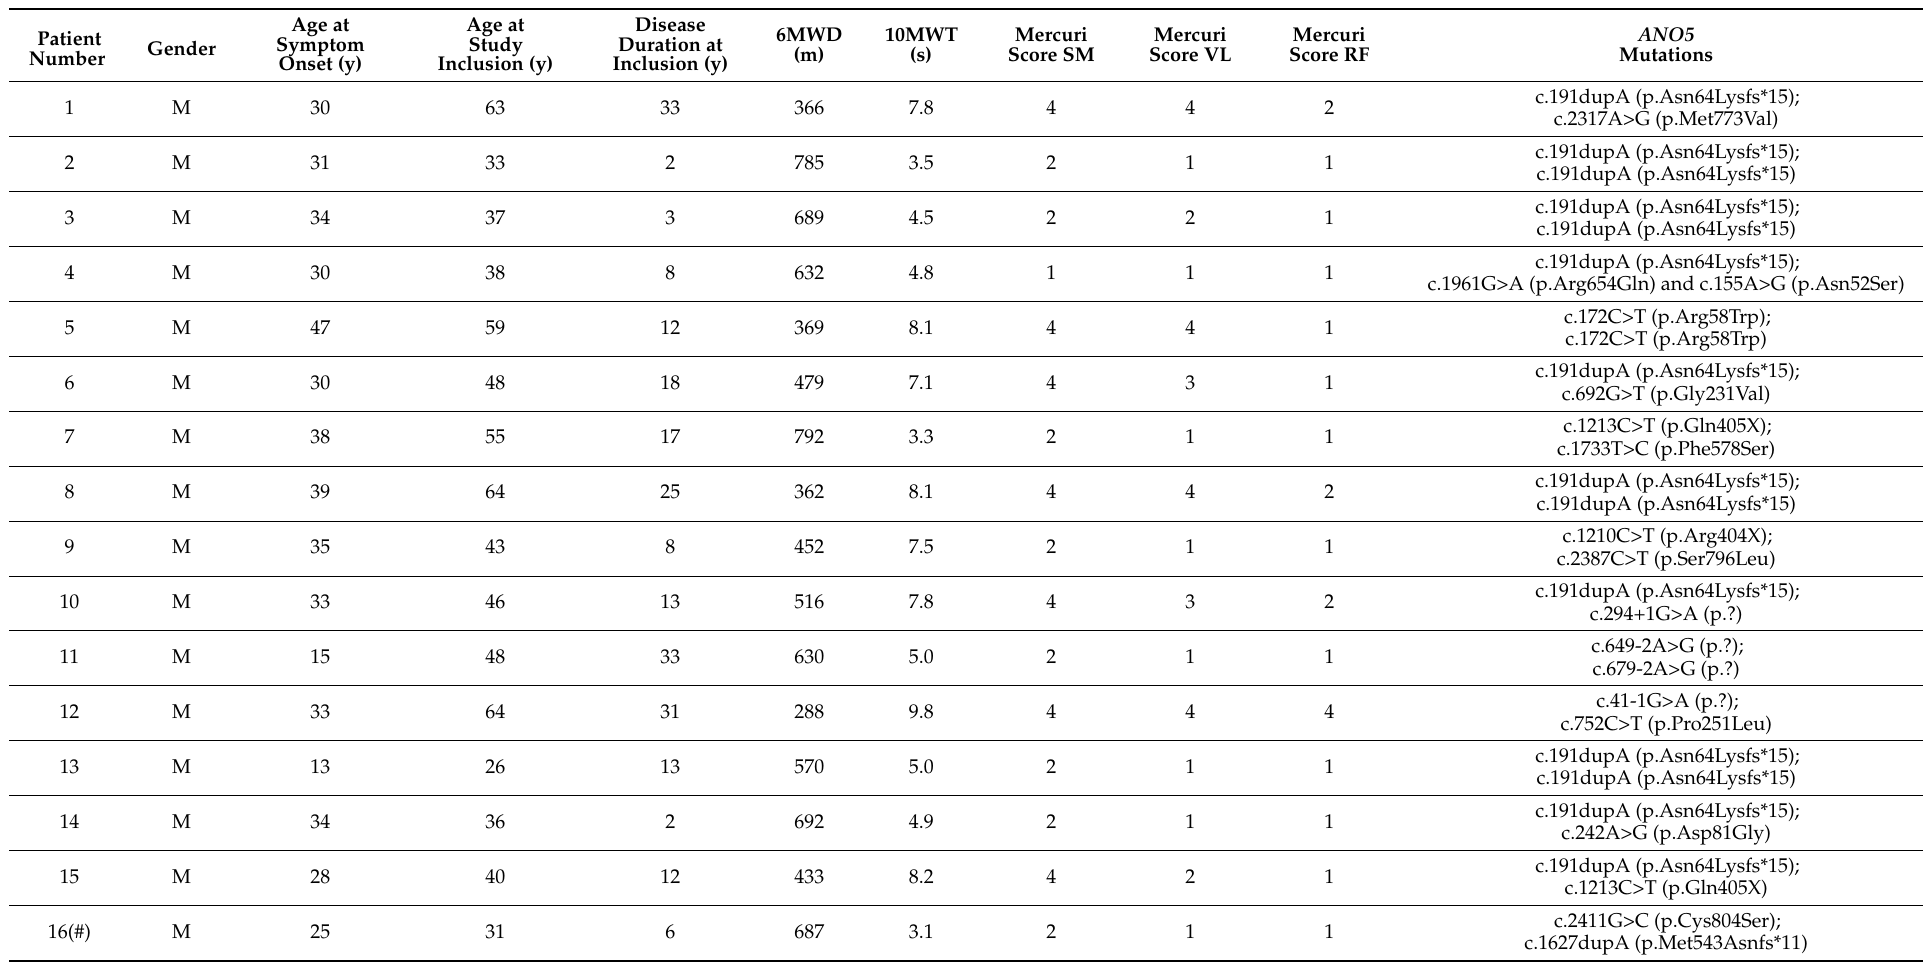
Table 1. Clinical and genetic features of the LGMD-R12 patients and MRI Mercuri scores of their biopsied